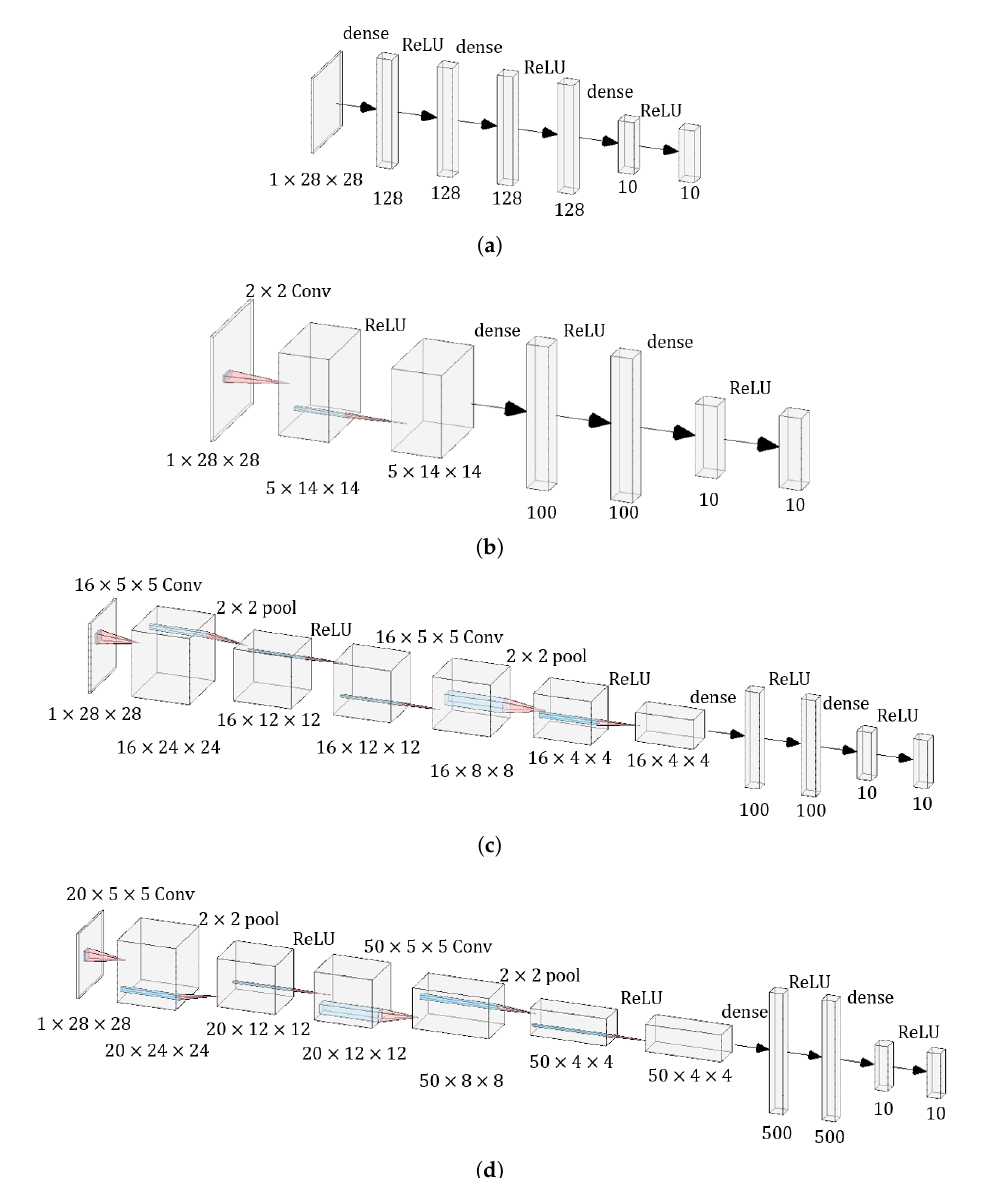
Figure 2. Four network architectures. ( a ) Network-A. ( b ) Network-B. ( c ) Network-C. ( d )